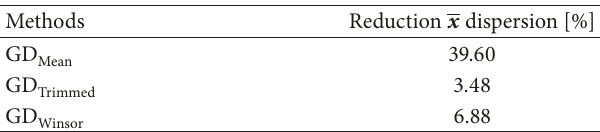
Table 62: G-h with 20 points.